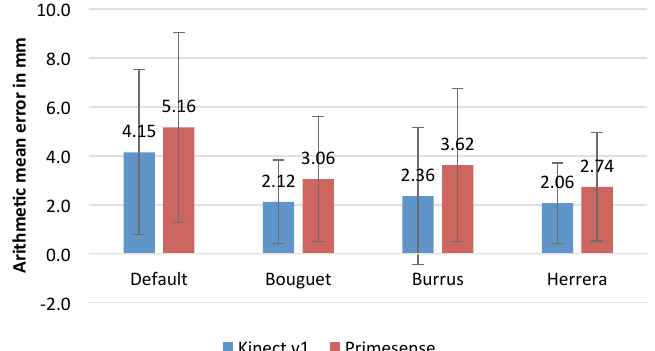
Figure 24. Registration error for different calibration methods in order to reconstruct a